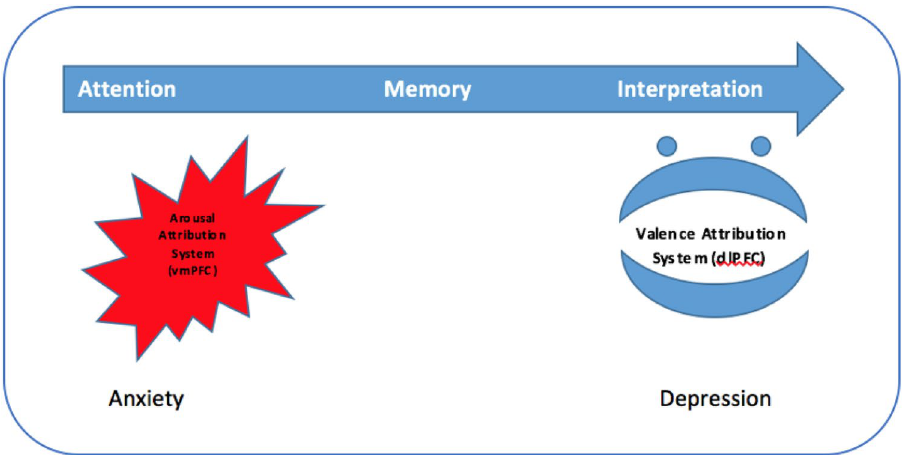
Figure 3. Emotional attribution system disorders in depression and anxiety. A schematic diagram for the assumed role of arousal and valence in the psychopathology of anxiety and depression. Abbreviations: dlPFC: dorsolateral prefrontal cortex, vmPFC: ventromedial prefrontal